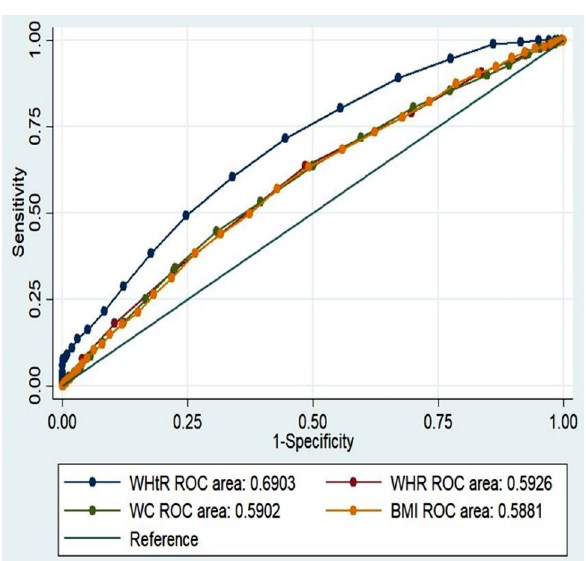
Figure 1. Comparison of AUC of the anthropometric indices for diagnosis of prevalent cardiac event in